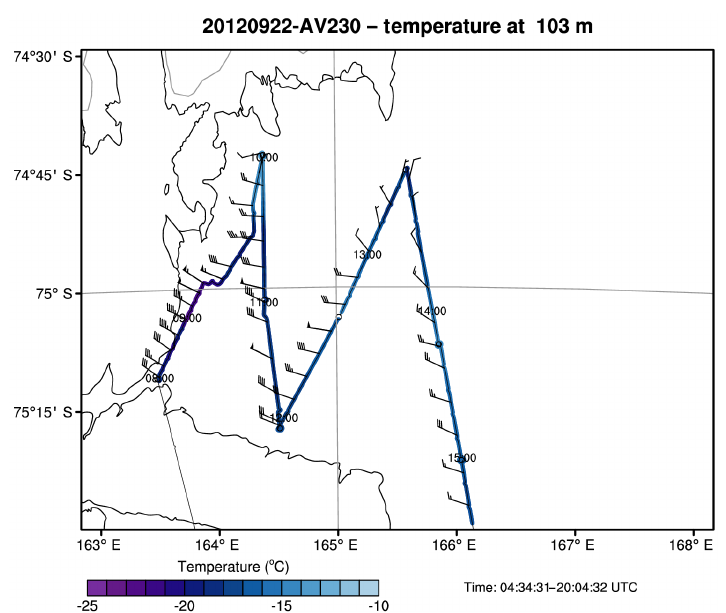
Figure 6. Sample of spatial plot – horizontal winds over TNB at 103 ± 10m flight level 22 September 2012 AV 230. Wind barbs are plotted with a half-barb = 2.5ms − 1 and a full-barb = 5.0ms − 1 . The color shading indicates air temperature at flight level.